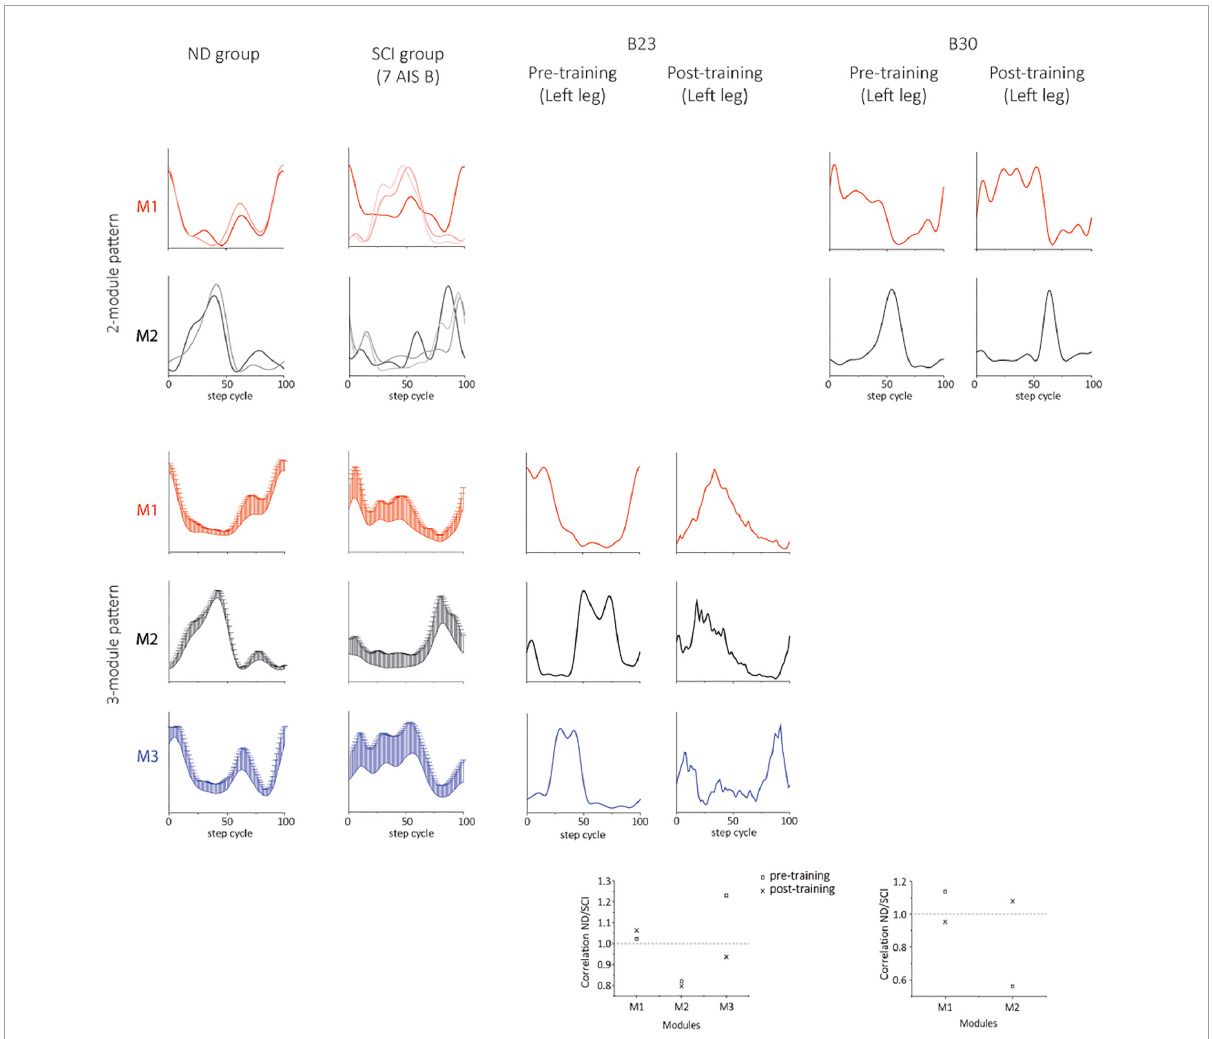
FIGURE6 Temporal synergy patterns from SF-NMF using 6 muscles in NDs, SCIs, and two successfully rehabilitated individuals (B23 and B30). Each panel shows temporal patterns from SF-NMF grouped by the number of modules that explain ≥ 90% variance in the EMG from 6 muscles of each leg. In the 2-module patterns of ND and SCI groups, each line represents a temporal synergy pattern from a leg. The 3-module patterns of ND and SCI groups represent group mean + SD. The scatterplots on the bottom represent the ratio of the maximum absolute correlation of each module. The ratio of greater than 1 indicates that the module exhibits greater similarity to the NDs than to the SCIs. See section “Materials and methods” for further